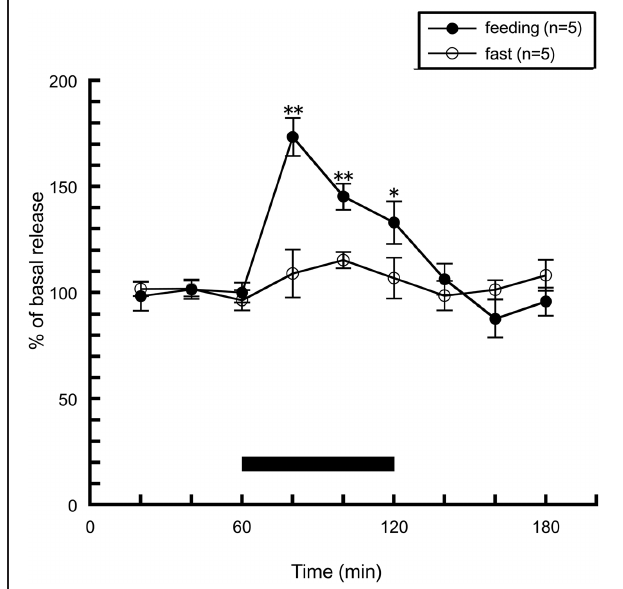
FIGURE 1 | The effects of feeding on the release of histamine from the rat anterior hypothalamus. The black bar indicates the 60min period when food was available. The mean values of three baseline samples preceding the feeding period were taken as 100%. Values are presented as percentages of the mean basal release ± SEM ∗ p < 0 . 05, ∗∗ p < 0 . 01 compared with the basal release of each